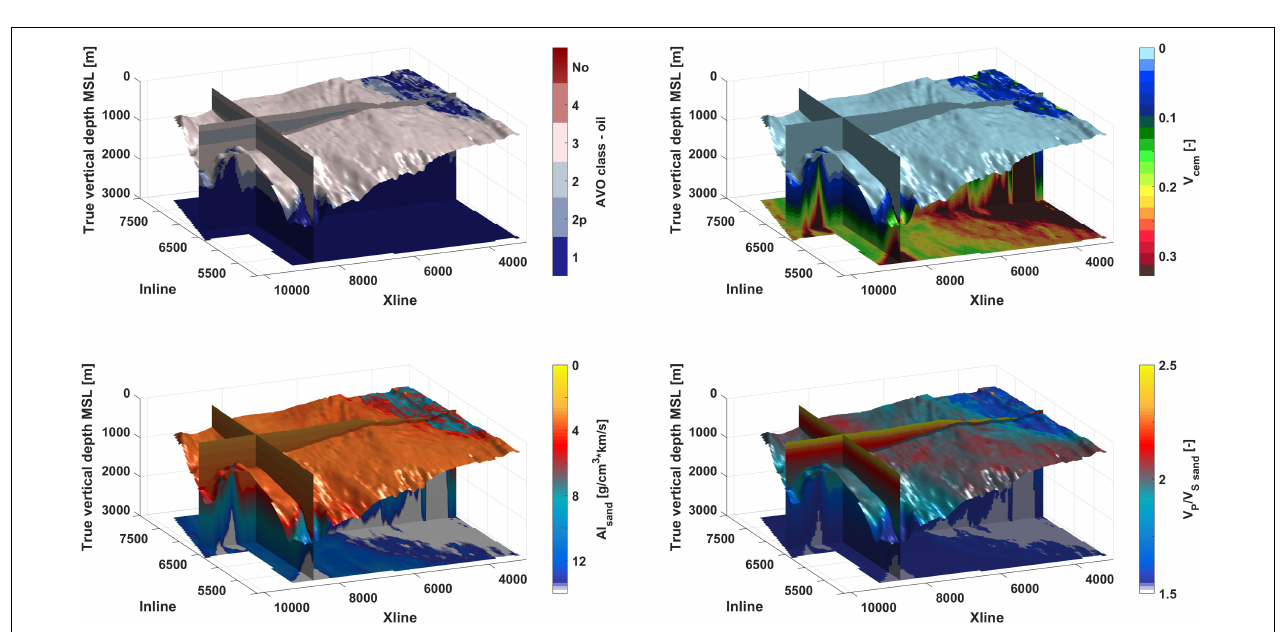
FIGURE 11 | Rock property and AVO feasibility cubes in a selected area of the Barents Sea. Oil-filled Tertiary sands show mostly class 3 AVO response in the area, and cement volume is 0, as the sands are not buried deep enough to be cemented (figure adapted from Avseth et al., 2020a).